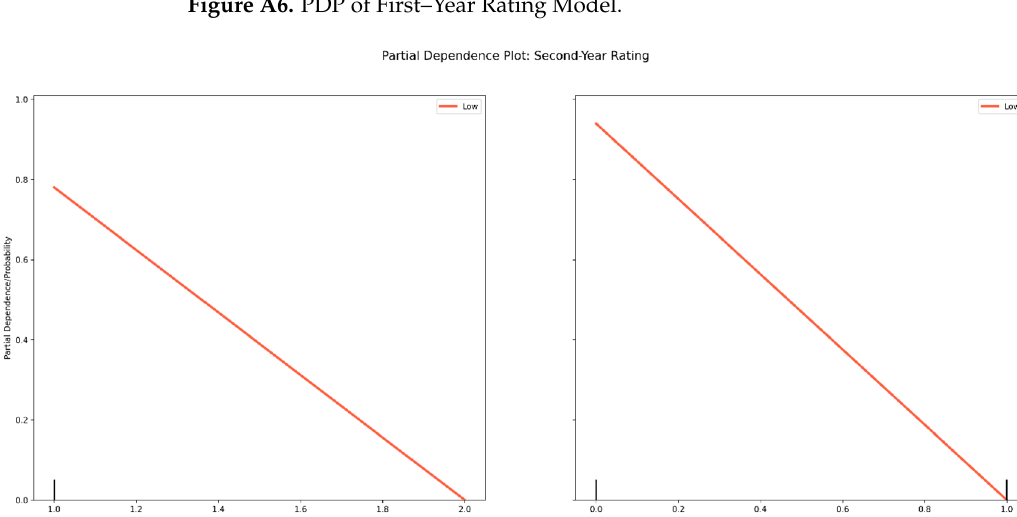
Figure A7. PDP of Second–Year Rating Model.